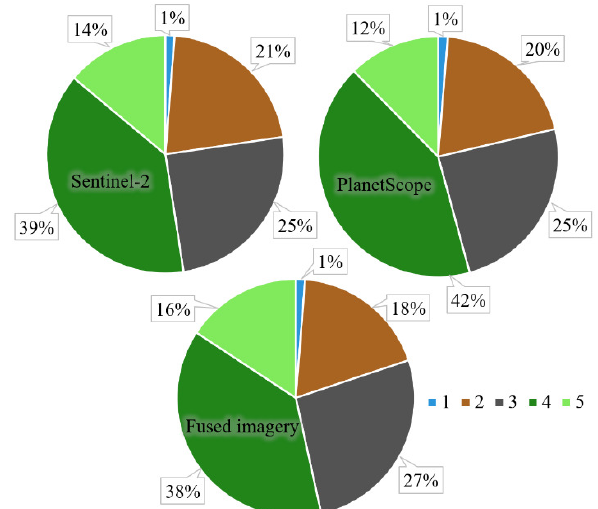
Figure 6. The share of land-cover classes in the entire study area for the classification based on the S-2, PS and fused imagery For the vegetation monitoring process, NDVI indices for S-2 and fused imagery are calculated. On figure 7 vegetation indices are shown.